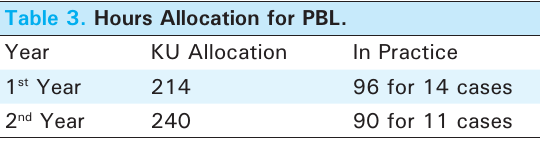
Table 3. Hours Allocation for